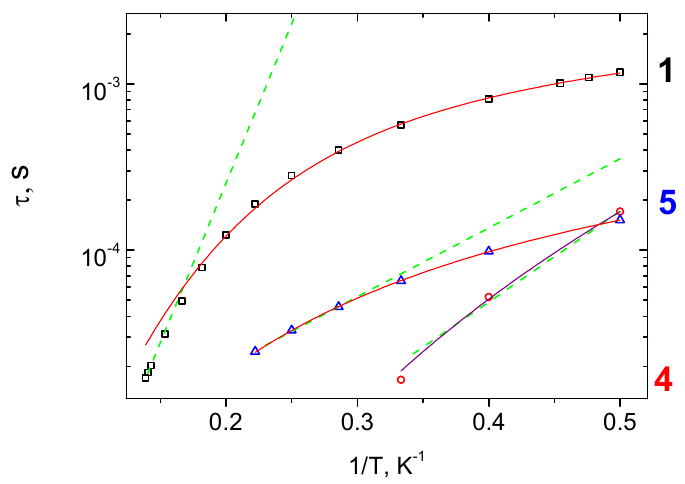
Figure 8. τ vs. 1/T plots for 1 , 4 and 5 under optimal dc-fields. Dashed lines represent approximations of high-temperature range by equation corresponding to Orbach relaxation mechanism [32–34]. Solid lines represent the fittings using Raman ( 4 ) and combined contribution of Raman and direct ( 1 , 5 ) relaxation mechanisms.